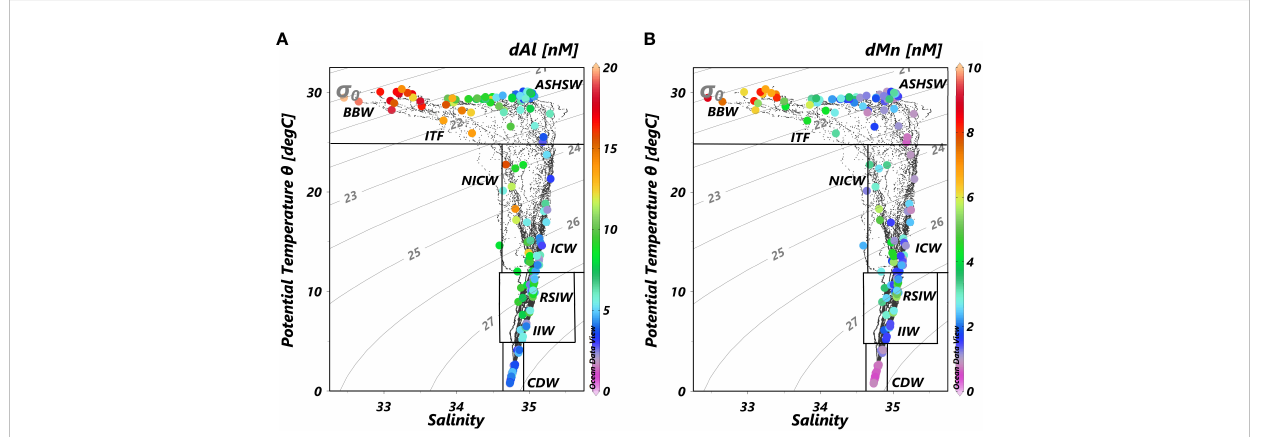
FIGURE 5 T-S diagrams of (A) dissolved Al and (B) dissolved Mn concentrations from stations in the northeastern IO. The gray solid curves were isopycnals with s 0 values (kg/m 3 ) denoted. The de fi nitions of different water masses were based on You (1997); You (1998), You (2000), Lewis and Luther III (2000), Sardessai et al. (2010), and Grand et al. (2015b). BBW, Bay of Bengal Water; ASHSW, Arabian Sea High Salinity Water; ICW, Indian Central Water; NICW, North Indian Central Water; IIW, Indonesia Intermediate Water; RSIW, Red Sea Intermediate Water; CDW, Circumpolar Deep